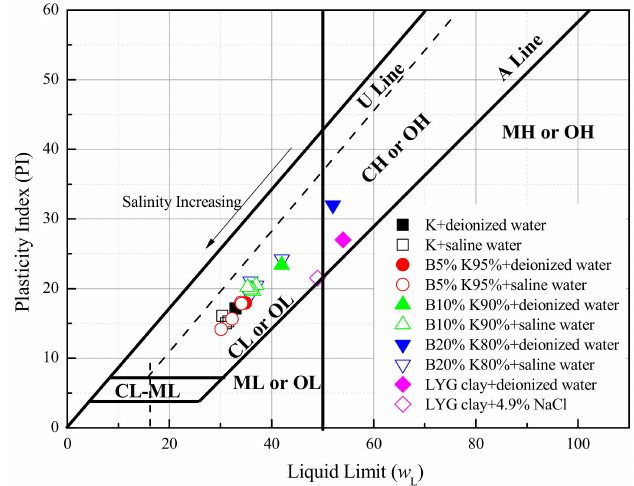
Figure 3. Liquid limits and plastic index comparison in plasticity